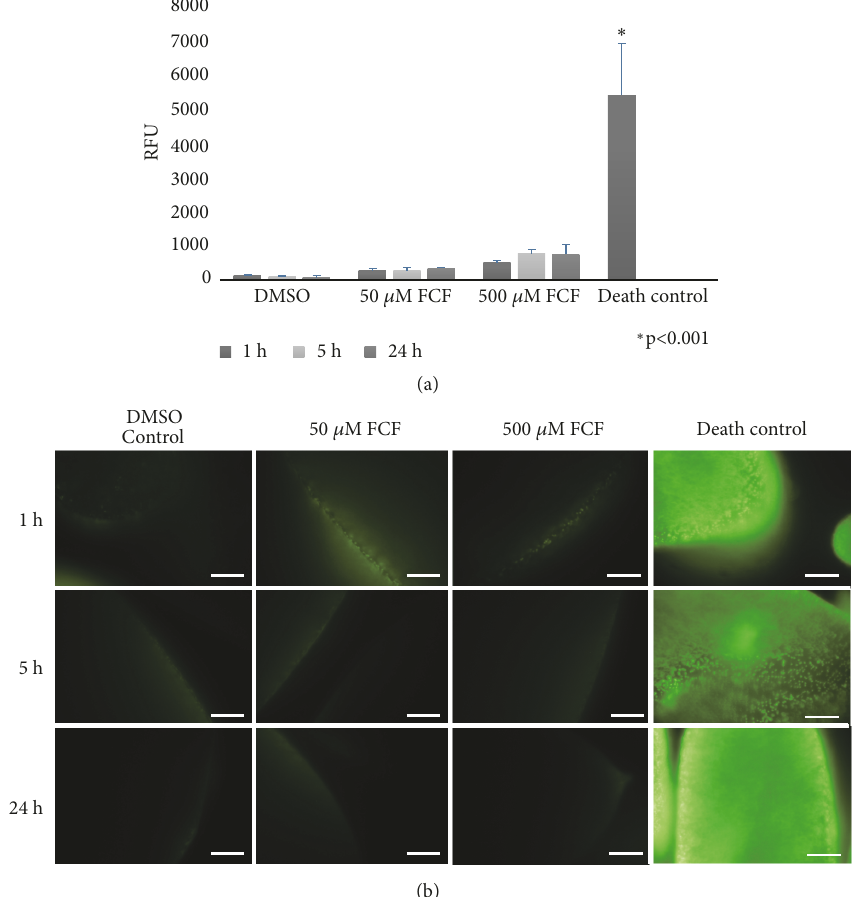
Figure 2: Viability assay of cysticerci treated with 50 and 500 𝜇 M FCF . Viability was analyzed by SYTOX green. (a) Quantification of RFUs of cells treated with DMSO control or FCF (50 or 500 𝜇 M) compared with that of the dead control cells. (b) Microscopic analysis of parasites incubated with SYTOX green after FCF exposure. Scale bars represent 500 𝜇 m. Bright-field images are shown in Supplementary Figure S4.